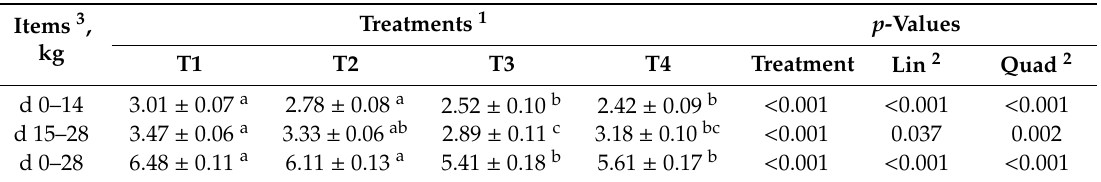
Table 4. E ff ects of the ratio of insoluble to soluble fiber in gestation diets on piglet weight gain during lactation.